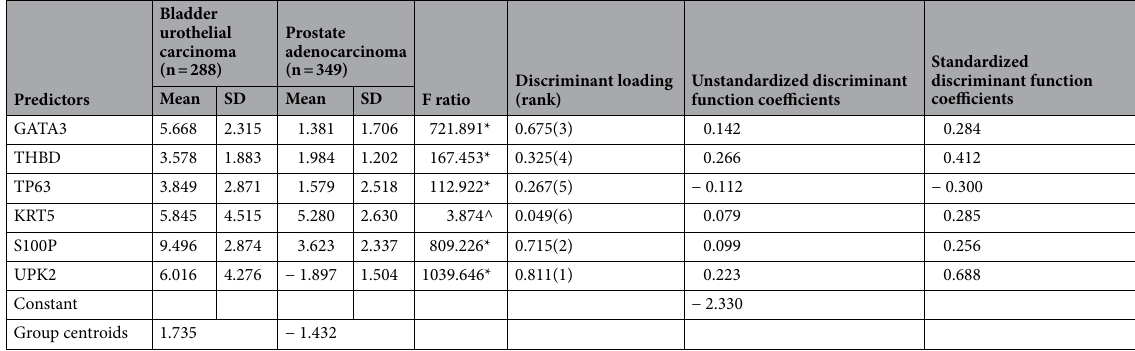
Table 4. Summary of interpretive measures for discriminant analysis based on urothelial lineage gene expressions. Discriminant function, D1 = 0.142(GATA3) + 0.266(THBD) − 0.122(TP63) + 0.079(KRT5) +